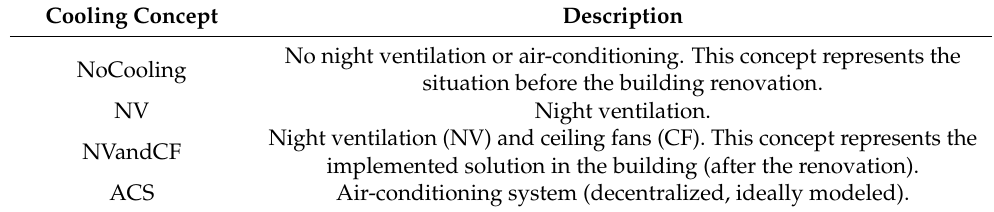
Table 3. Simulated cooling